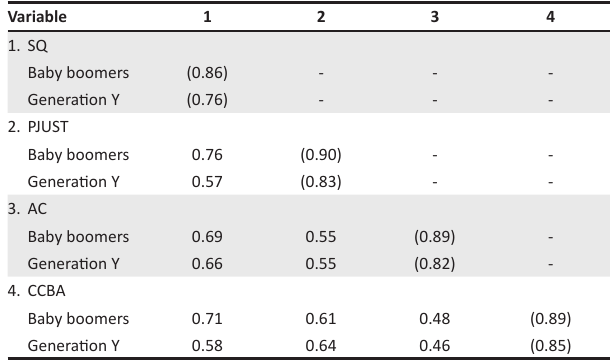
TABLE 3: Latent factor correlation matrix with average variance extracted values on the diagonal in